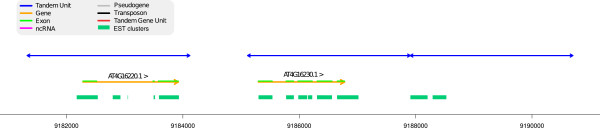
A TU that could contribute to a modified annotation. Region 9,181,000-9,191,000 of chromosome 4. In this TA, two TU match with coding genes but the third TU matches to no annotated element. However, there are EST matching in the 3rd region (extracted from Gramene web site, Ensembl Plants Arabidopsis thaliana version 62.10) and an associated FGENESH predicted gene (not shown), suggesting the existence of a 3rd transcribed region.